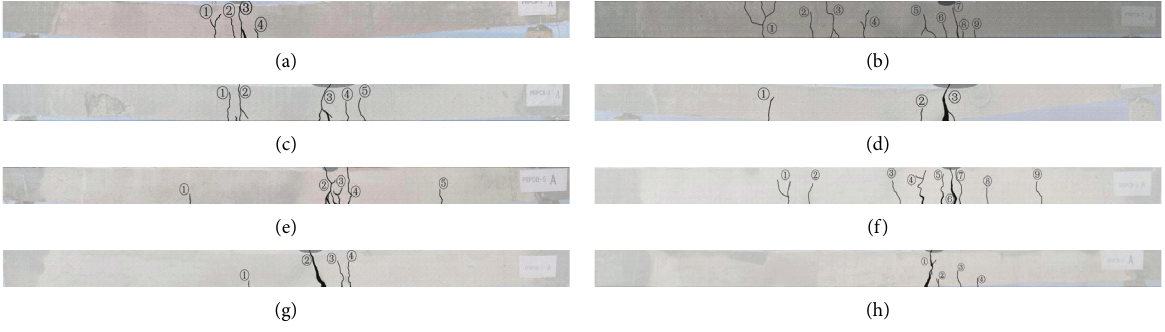
Figure 14: The crack distributions for the specimens. Note that the shadows above the maximum crack of the specimens in the figures show the crushed concrete in the compression zone. (a) PRPCB1. (b) PRPCB2. (c) PRPCB3. (d) PRPCB4. (e) PRPCB5. (f) PRPCB6. (g) UPRPCB1. (h) UPRPCB2. Table 4: Residual bearing capacity results of the specimens. Specimen